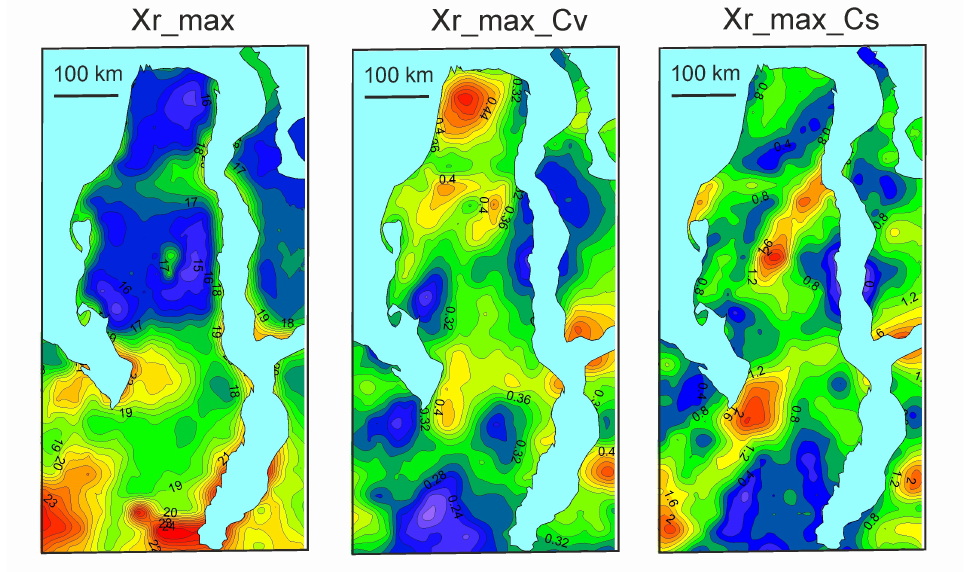
Figure 26. Spatial distributions of daily maximum of surface runo ff X r_max , its temporal variability C v and skewness C s for the period of summer rains on the Yamal peninsula